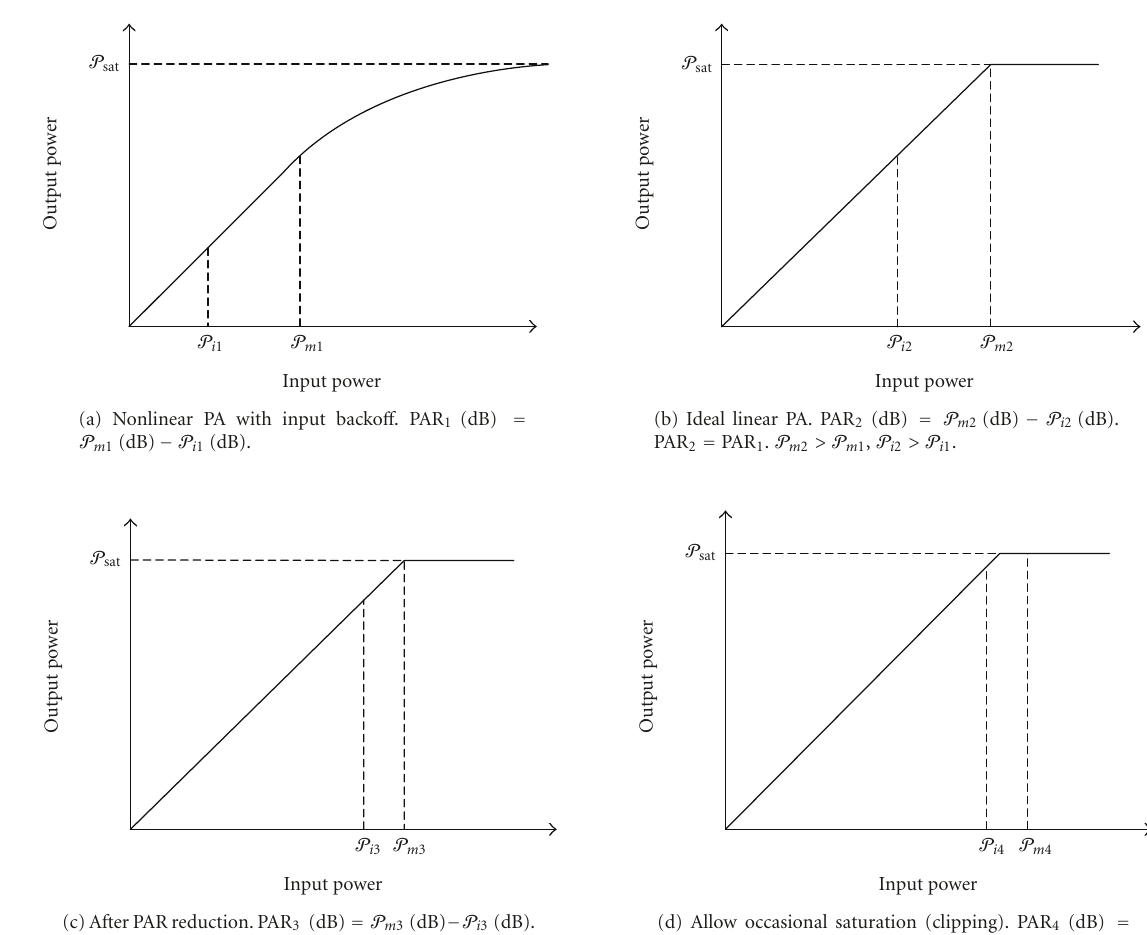
Figure 1: PA linearization and PAR reduction can improve the PA e ffi ciency by reducing the amount of backo ff that is needed. From (a)–(d), the average input power P i 4 > P i 3 > P i 2 > P i 1